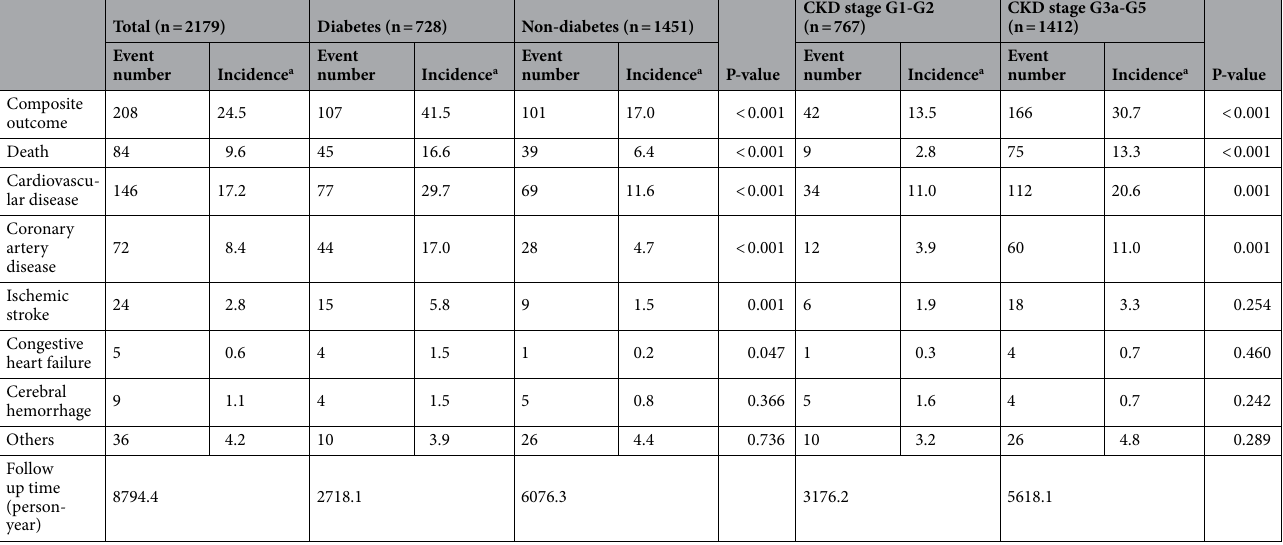
Table 1. Incidence of cardiovascular disease, death, and composite outcome in the KNOW-CKD cohort. P-value from Poisson regression model in the incidence comparisons of diabetes vs. non-diabetes and